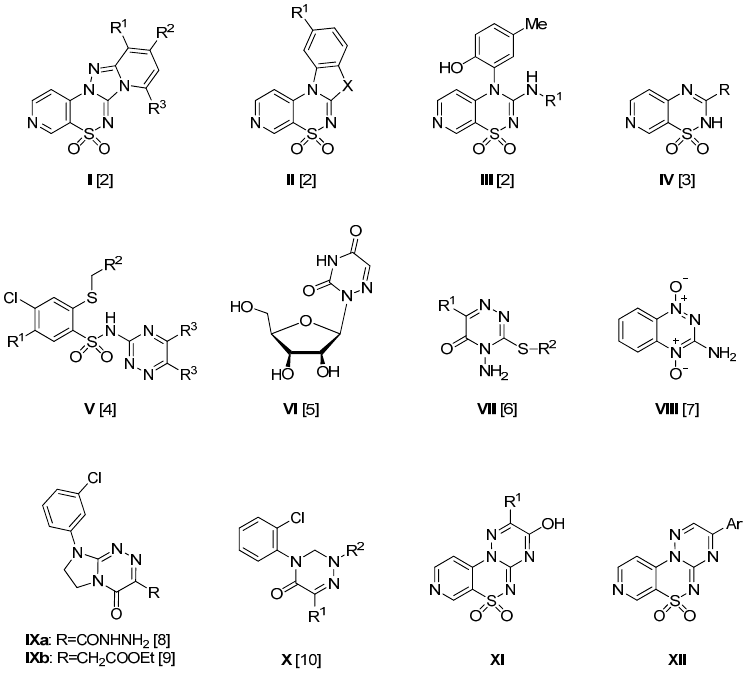
Figure 1. Structures of known anticancer and antibacterial pyridinethiadiazine derivatives I – III